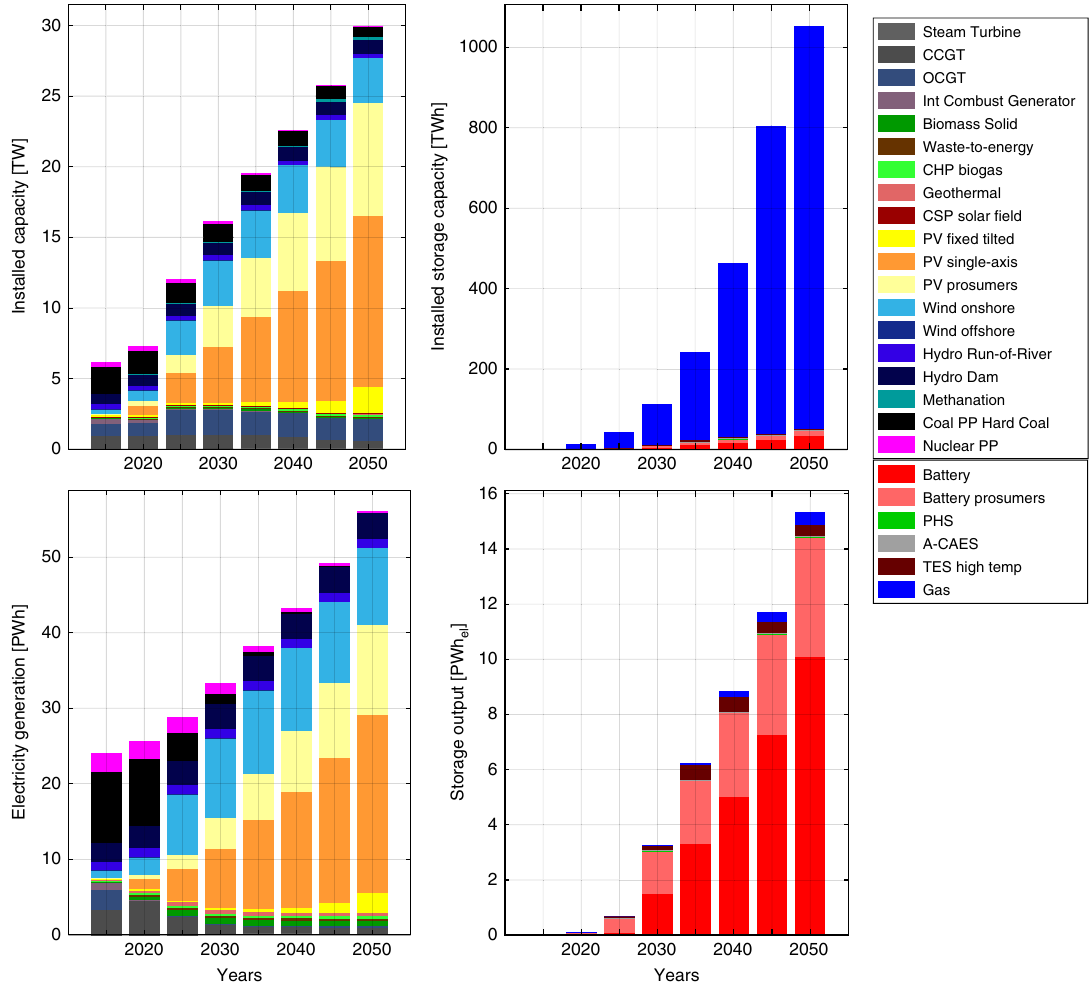
Fig. 3 Power and storage capacities, power generation and storage throughput from 2015 to 2050. During the fi rst steps of the transition most of new installed capacities are represented by wind turbines, as the least cost source of electricity during this time in most regions. Later with cost decline of PV and battery storage technologies, and utilization of most ef fi cient wind generation sites, the share of PV in new installed capacities becomes dominant. Some wind turbine capacities are reinstalled in the later periods of the transition to substitute decommissioned old turbines. Overall growth of cumulated installed capacities is initiated by both growth of the power demand and the generally lower FLh of RE sources. Substantial growth of storage technologies capacities starts after 2030, when the VRE generation share exceeds 50% in most of the regions. PV photovoltaics, RE renewable